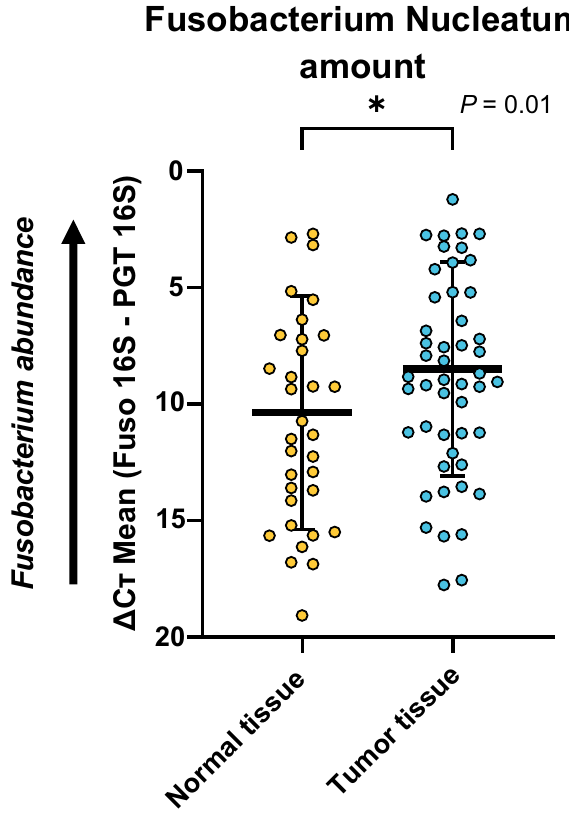
Figure 1. Relative amount of Fusobacterium nucleatum ( Fn ) in the tumor (n = 34, ΔCT mean: 8.47) tissue and adjacent normal (n = 51, ΔCT mean: 10.36) tissues. Asterisk indicates significant differences between the ΔCT mean of the tumor and adjacent normal tissues (* P <